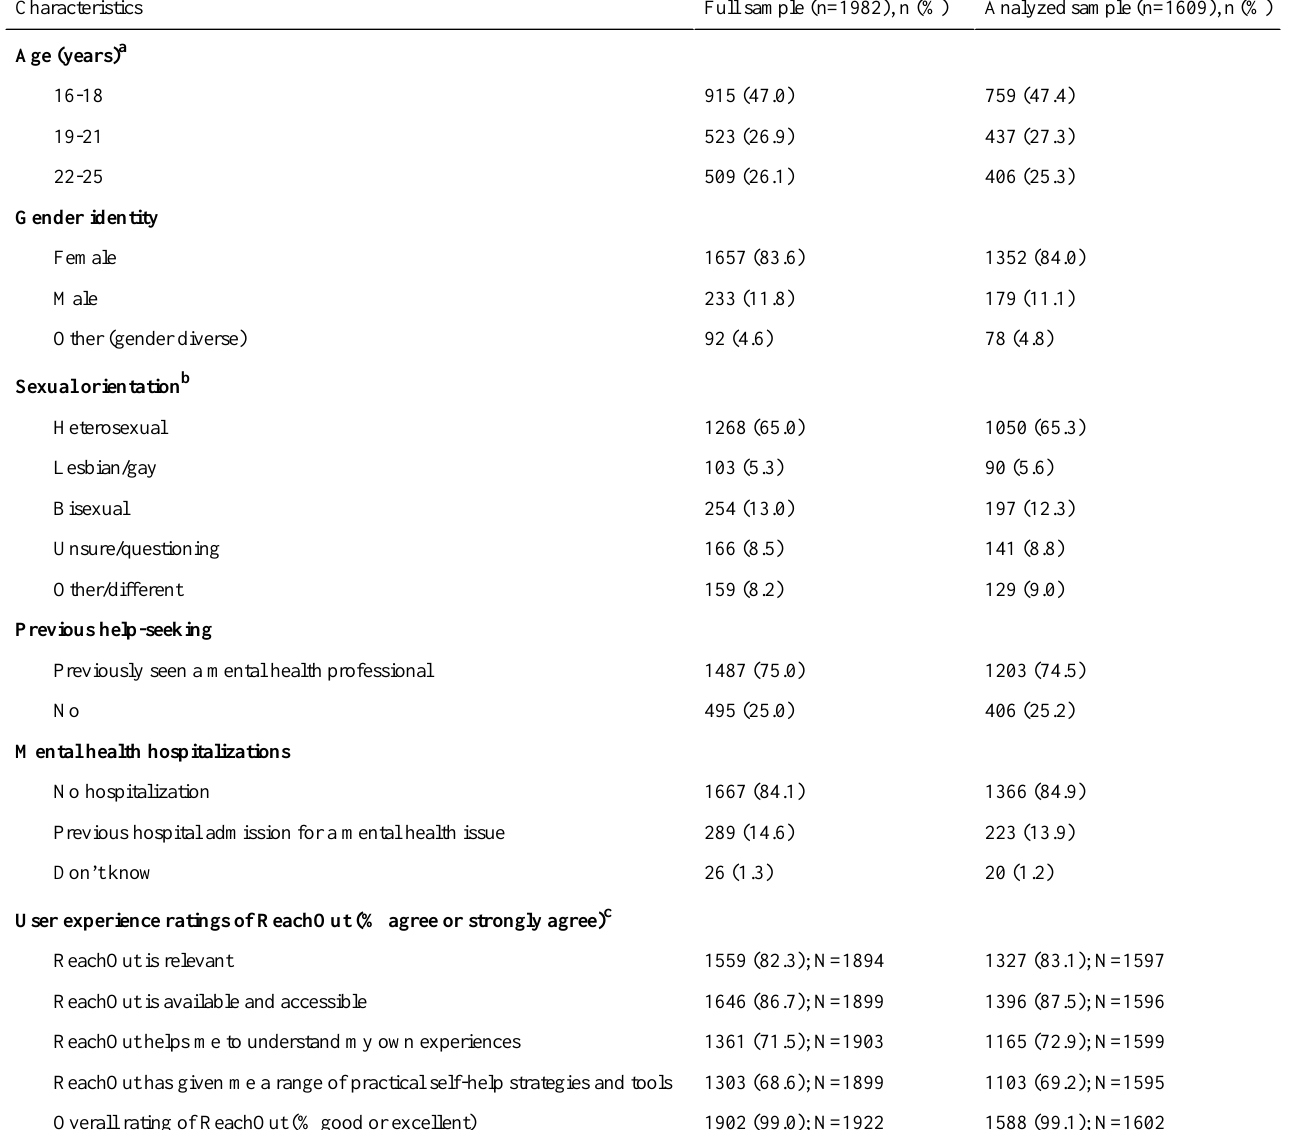
Table 1. Participant baseline